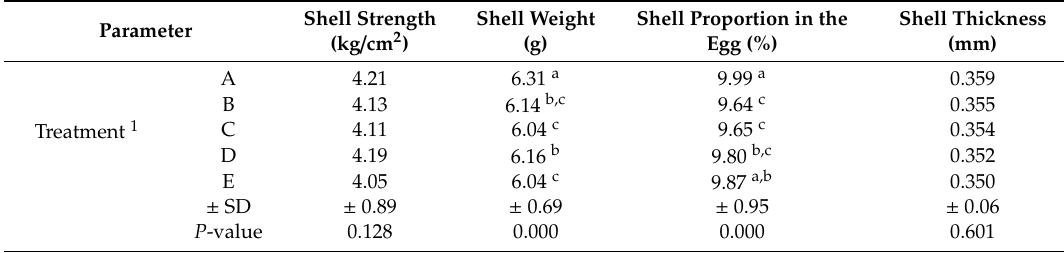
Table 4. Eggshell parameters (means ± SD